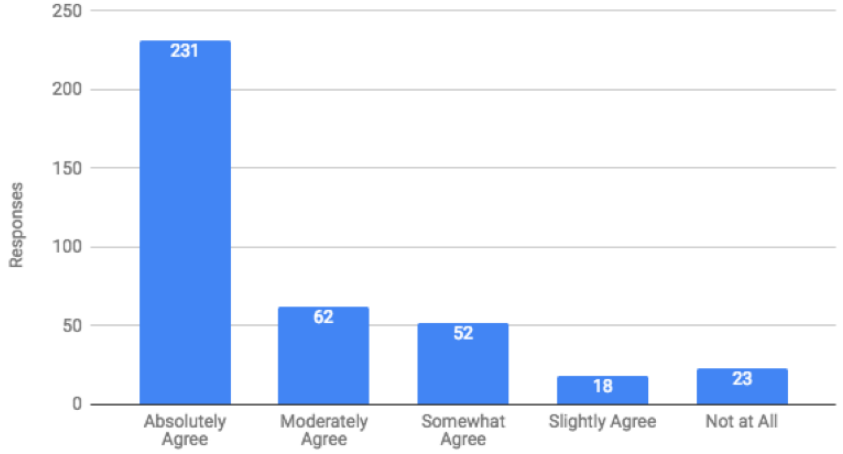
Figure 4. Question 24: Religion Should be Taught in a Positive Way in RE ( N = 386).